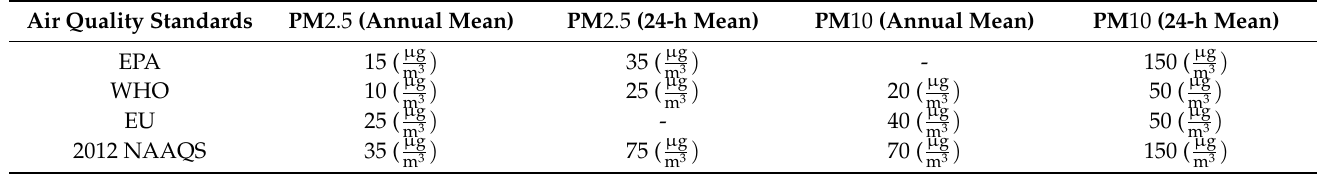
Table 1. Air quality standards defended by the U.S Environmental Protection Agency, the World Health Organization, the European Union, and the Chinese 2012 National Ambient Air Quality Standards. Air Quality Standards